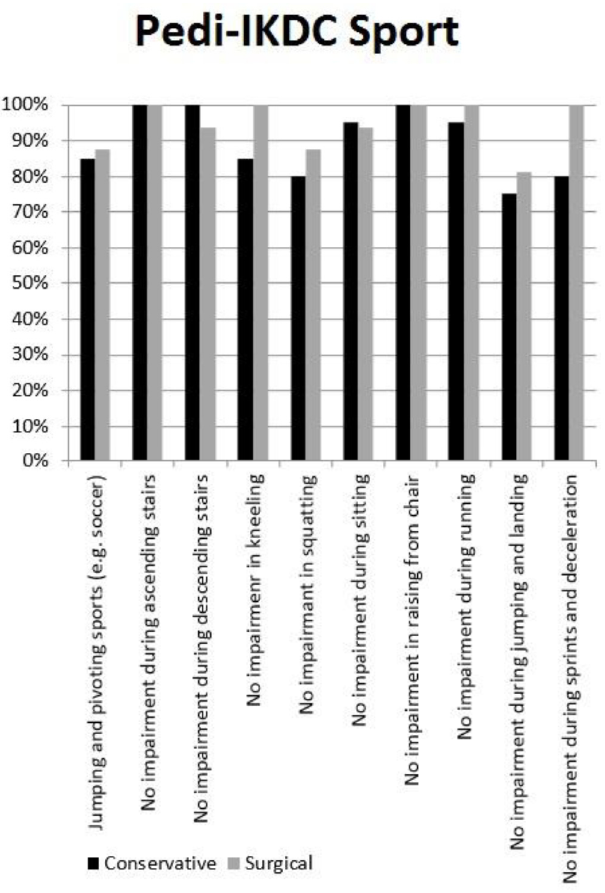
Figure 3. Pedi-IKDC Sport. Figure 3. Pedi ‐ IKDC Sport.